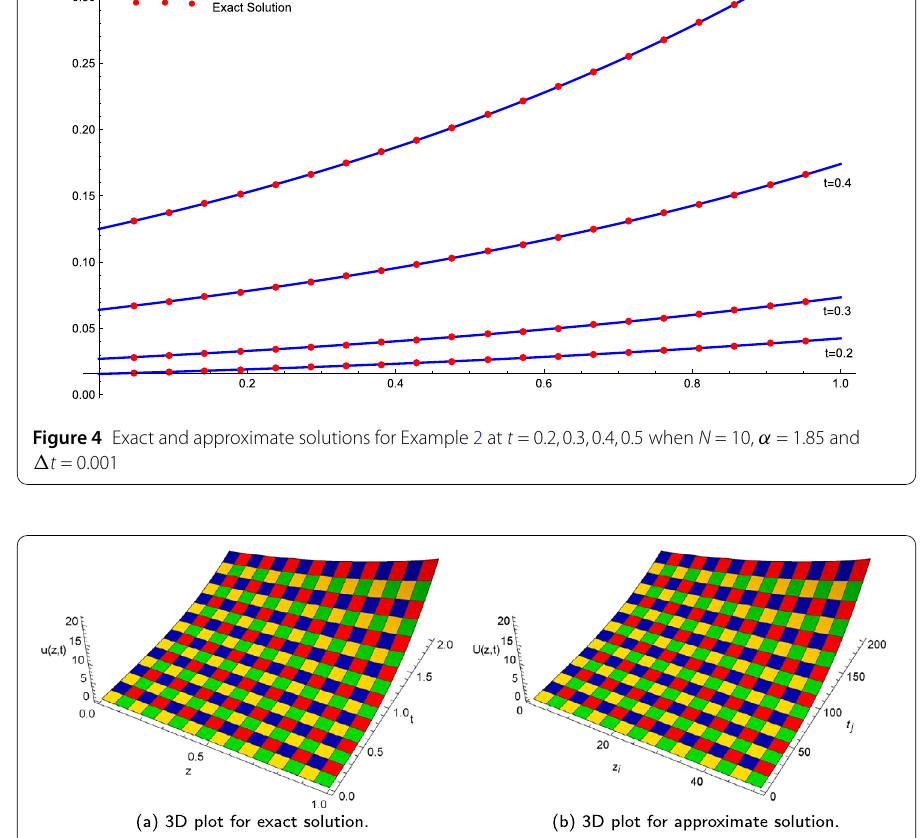
Figure 5 Exact and approximate solutions for Example 2, when N = 50, α = 1.25, t = 2 and (cid:11) t = 0.01